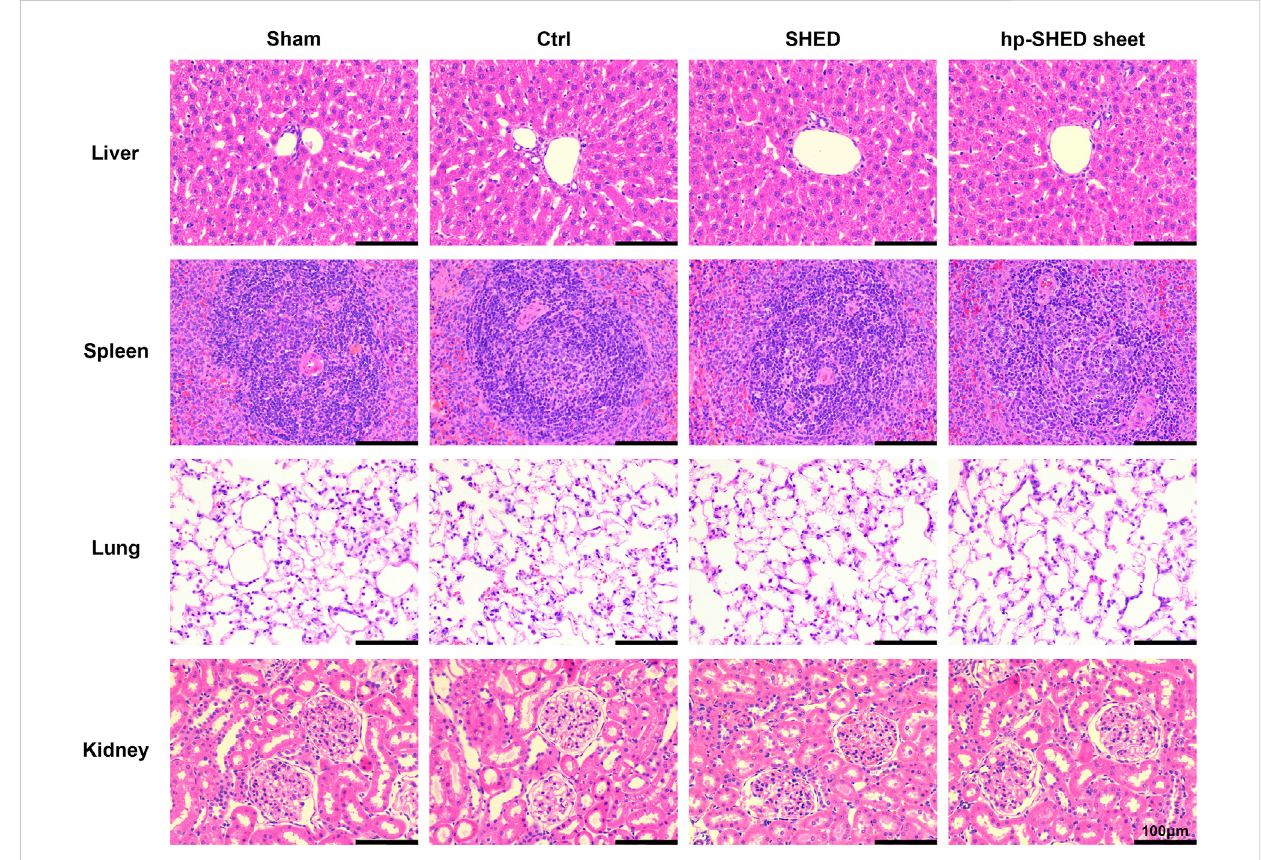
FIGURE 4 The HE staining of liver, spleen, lung and kidney in each group of rats on the 60th day